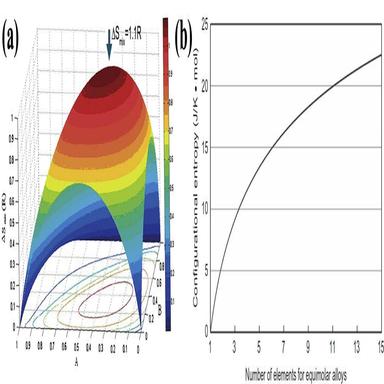
(a) Illustration of the ΔSmix for a ternary alloy system with the composition change, and (b) Entropy of mixing ΔSmix as a function of the number of components for equiatomic alloys in the random solution state.